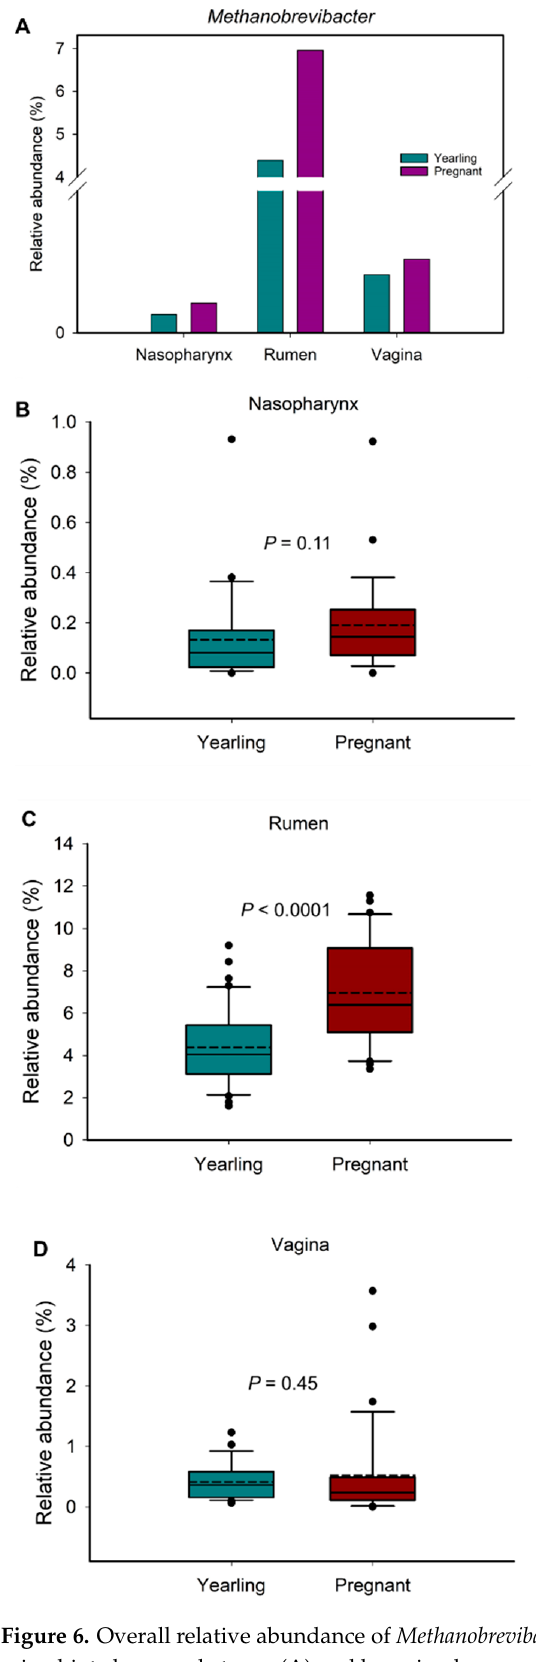
Figure 6. Overall relative abundance of Methanobrevibacter in nasopharyngeal, ruminal and vaginal microbiota by sample types ( A ) and by animal groups ( B – D ).